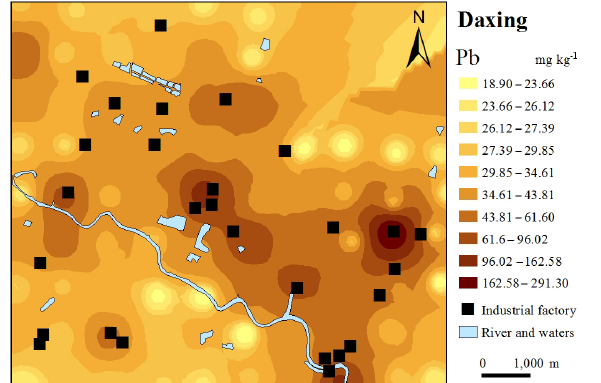
Figure 4. Filled contour map generated by inverse distance- weighted interpolation showing the spatial distribution of soil Pb concentrations in the Daxing area (generated using the Inverse Dis- tance Weighting spatial analyst tool of the ArcGIS software pack- age).